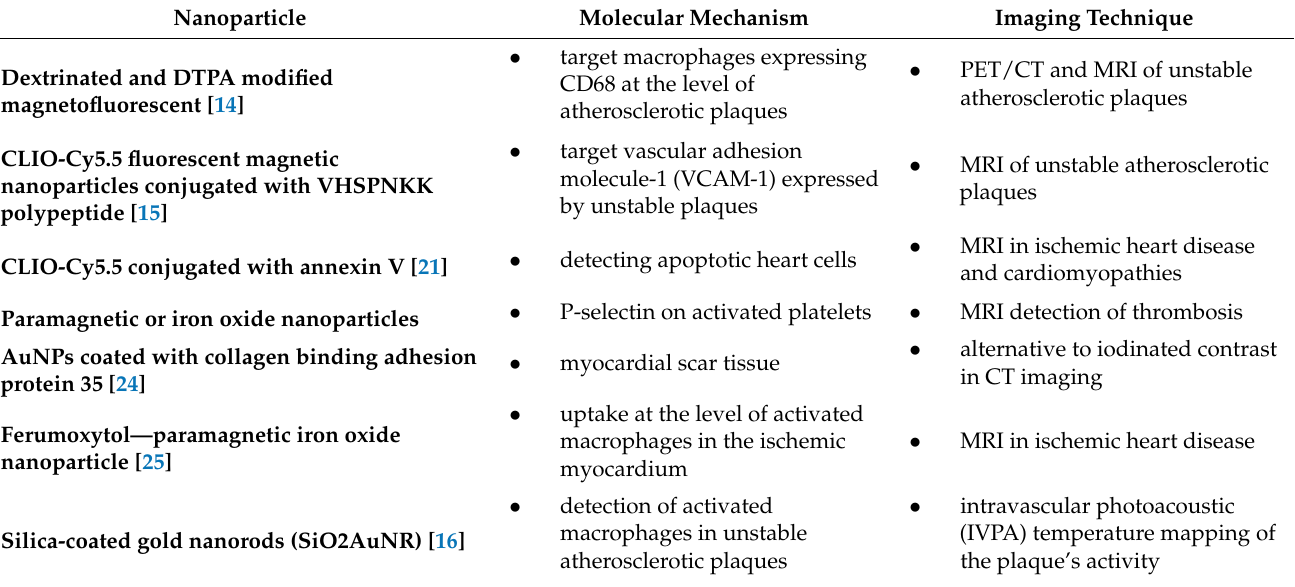
Table 1. Nanoparticles used in cardiovascular imaging and